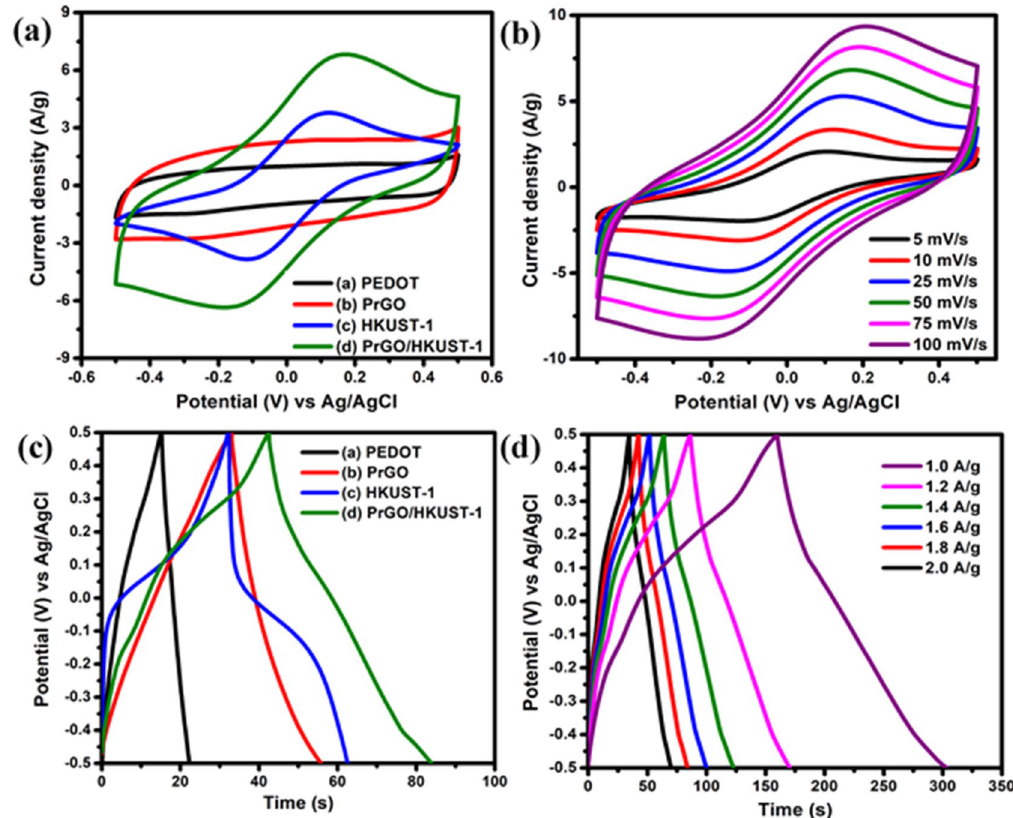
Figure 4. ( a ) CV curves of PEDOT, PrGO, HKUST-1 and PrGO/HKUST-1 at 50 mV/s, ( b ) CV curves of PrGO/HKUST-1 at various scan rates (5–100 mV/s), ( c ) GCD analysis of PEDOT, PrGO, HKUST-1, PrGO/ HKUST-1 and ( d ) GCD plots of PrGO/HKUST-1 at various current density (1.0–2.0 is 360.5 F/g where it is significantly greater compared to HKUST-1 (103.1 F/g), PrGO (98.5 F/g) and PEDOT (50.8 F/g) at a scan rate of 5 mV/s. Figure 5(b) implies the CV curves of symmetrical PrGO/HKUST-1 from the scan rate of 5 to 100 mV/s. The current density and the area under the CV curves increase evidently as the scan rate is increased. The relationship between C sp and scan rate is elucidated in Fig. 5(c) and the results confirm that the C sp reduces over the increasing scan rate. At slower scan rates, the electrolyte ions are able to utilize all the electroactive sites of the material and lead to a complete redox reaction, which provides high C sp 4 . However, at faster scan rates, the movement of electrolyte ions is time limited which means that only the outer electroactive sites of the material are involved for energy storage, resulting in low C sp 46 . Interestingly, PrGO/HKUST-1 exhibits higher C sp compared to other materials, proving incorporation of HKUST-1, PEDOT and rGO can successfully boost the electrochemical performance of PrGO/HKUST-1 composite, which mainly caused by the faradic redox reaction that occurs at the surface of electroactive material 47 . The C sp achieved in this work is higher in comparison to other reported HKUST-1 based supercapacitors (Table 1). Trasatti method was performed to evaluate the individual capacitance contribution (EDLC and pseudo- capacitance) from the total capacitance ( C t ) 51 . The EDLC (surface charge) capacitance (C EDLC ) is achieved by retrieving the y-axis intercept of plot C sp vs 1/square root of scan rate ( v −1/2 ) (Eq. (3)). Whereas, Eq. (4) is used to determine the C t by extracting the 1/C t value (y-axis intercept of plot 1/ C sp vs square root of scan rate ( v 1/2 )). The capacitance difference between C t and C EDLC is expressed as the diffusion-controlled charge (pseudocapacitance, C PC ) 52 . Figure 5(d) denotes the relationship between C sp and v −1/2 . PrGO and PrGO/HKUST-1 illustrate C EDLC of 33.2 F/g and 27.1 F/g, respectively. Meanwhile, PEDOT and HKUST-1 depict minimal C EDLC , designating the pseudocapacitive behavior of the samples. The C t values of the as-prepared samples are retrieved from Fig. 5(e). The percentage of C EDLC (% C EDLC ) and C PC (% C PC ) contribution in the samples are calculated utilizing Eqs. (5) and (6), respectively. The presented bar chart (Fig. 5(f)) illustrates a maximum % C PC of 99.9% for both PEDOT EDLC = 24.2% and % C PC = 75.8%) and PrGO/HKUST-1 (% C EDLC = 2.9% and % C PC = 98.1%) demonstrate hybrid supercapacitive behavior with both surface charge and diffusion-controlled charge.